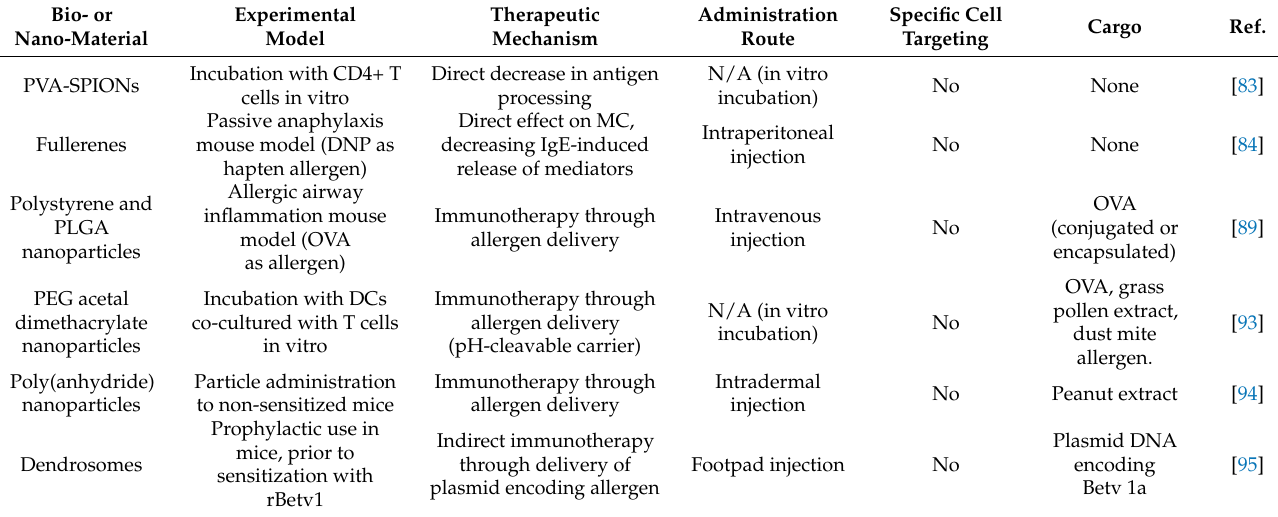
Table 1. Main characteristics of the bio- or nano-material-based strategies for allergy therapy described in the article, in the order in which they appear in the